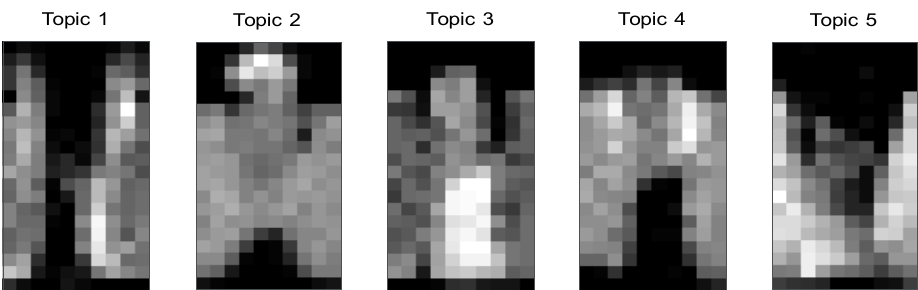
Figure 2. Latent Dirichlet Allocation (LDA) results for a 5-topic model. These are images which define the clusters or topics. Each topic definition is a list of probabilities or densities for each pixel.